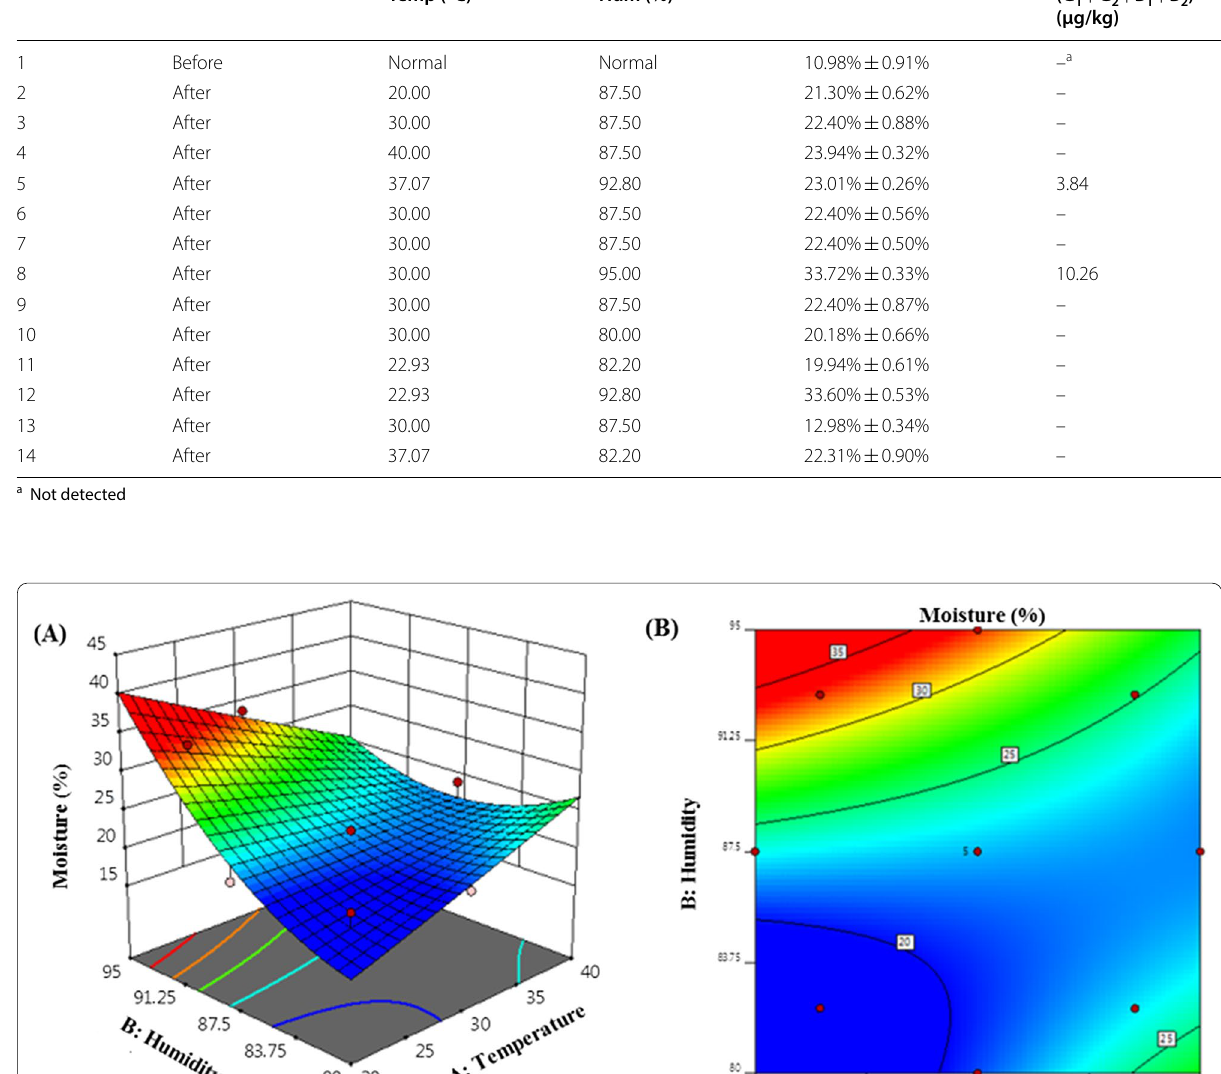
G B B ) in A. rhizoma after incubation with Aspergillus flavus for storage at different 1 + 2 + 1 + 2